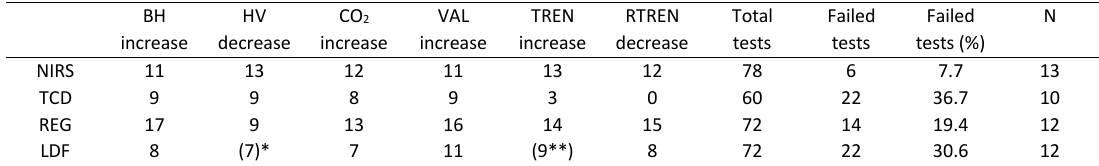
Table 2. Summary of tests and responses by modalities: BH (breath holding); HV (hyperventilation); CO 2 (CO 2 inhalation); VAL: Valsalva maneuver; TREN (Trendelenburg position); R TREN (reverse Trendelenburg position); N (number of measured subjects). In case of NIRS and TCD Trendelenburg measurement showed multyphasic change, not just increase or decrease in 7 (NIRS) and 10 cases (TCD). Exceptions : *LDF increased; **LDF decreased; NIRS and TCD showed multiphasic reactions for Trendelenburg and reverse Trandelenburg